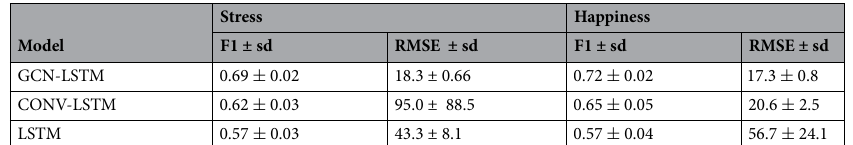
Table 1. Performance comparison between different models. ANOVA test is conducted for statistical significance between different models. The test showed that all means reported in the table are statistically different for both stress (F1 p-value = 7.5 × 10